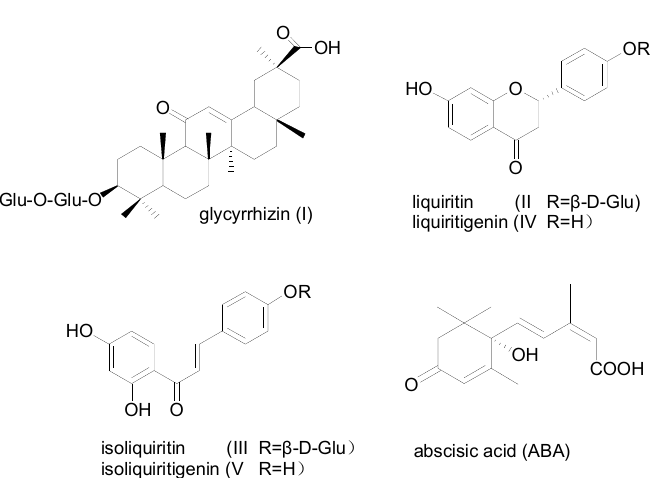
Figure 1. Chemical Structures of glycyrrhizin ( I ), liquiritin ( II ), isoliquiritin ( III ), liquiritigenin ( IV ), isoliquiritigenin ( V ), and abscisic acid (ABA).